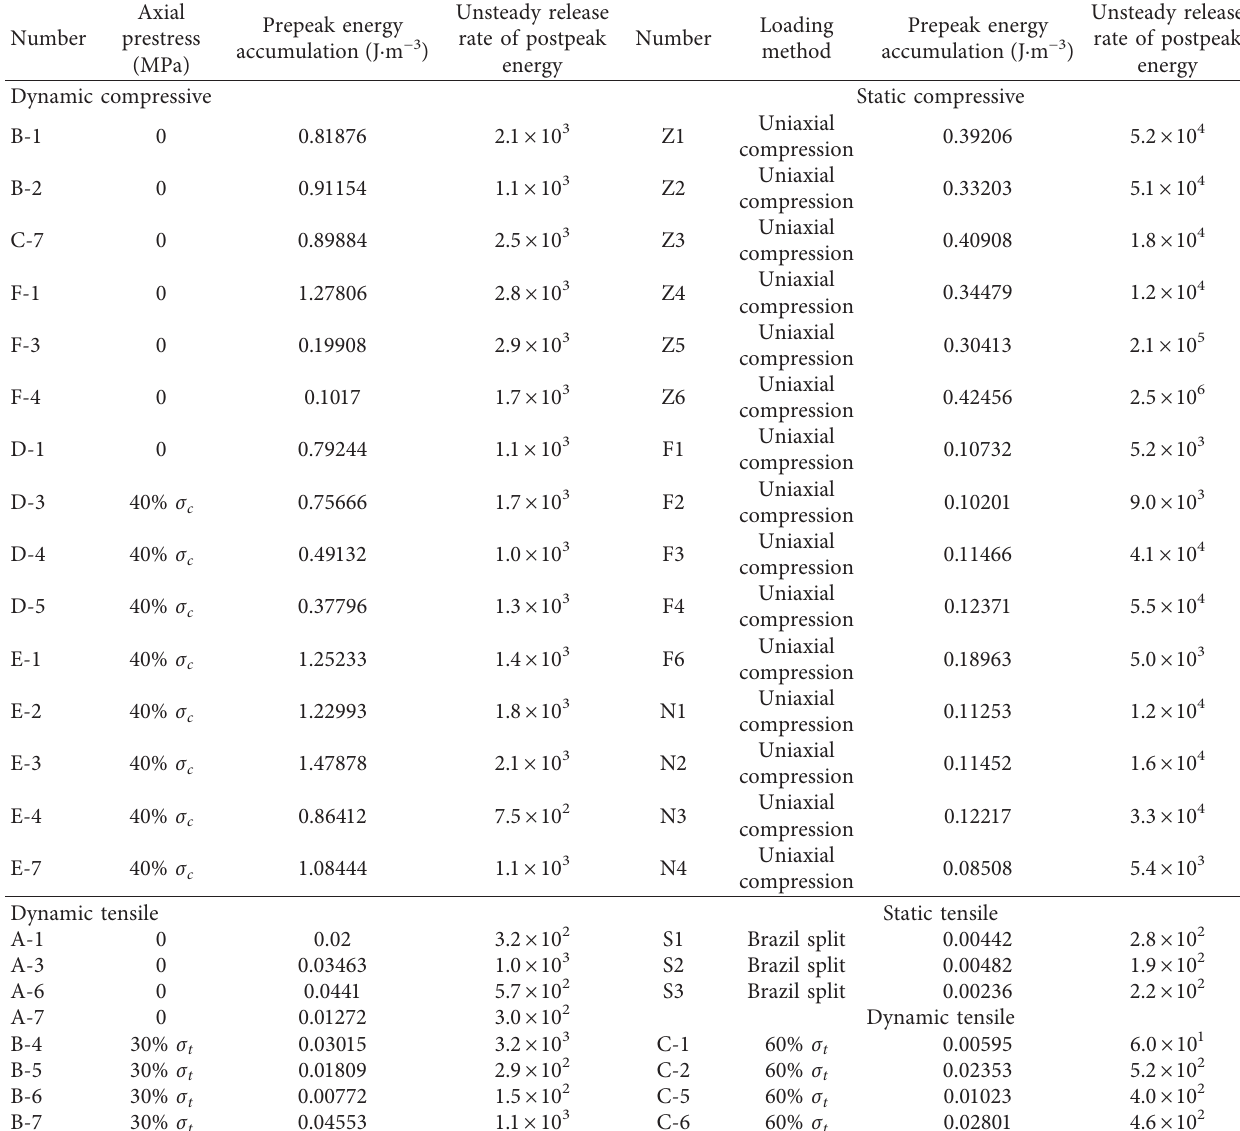
Table 2: Calculation results of energy accumulation and release rate under different loading states of